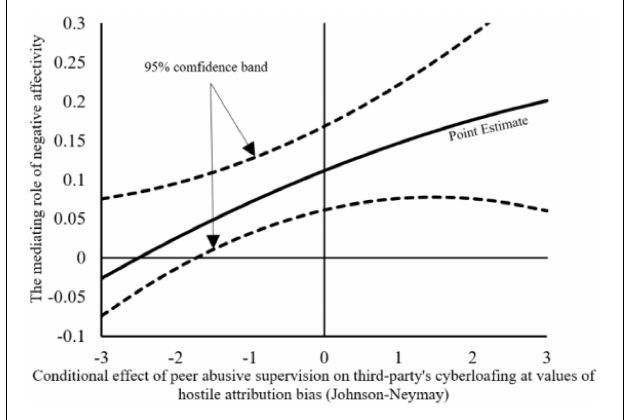
FIGURE 3 | Conditional effect of peer abusive supervision on third party’s cyberloafing at values of third party’s hostile attribution